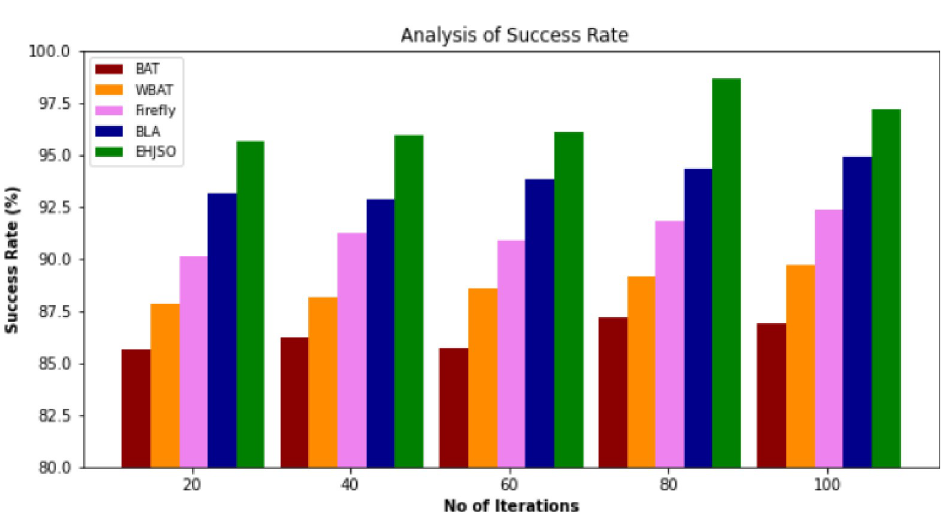
Fig 8. Success rate analysis for EHJSO method with existing system.